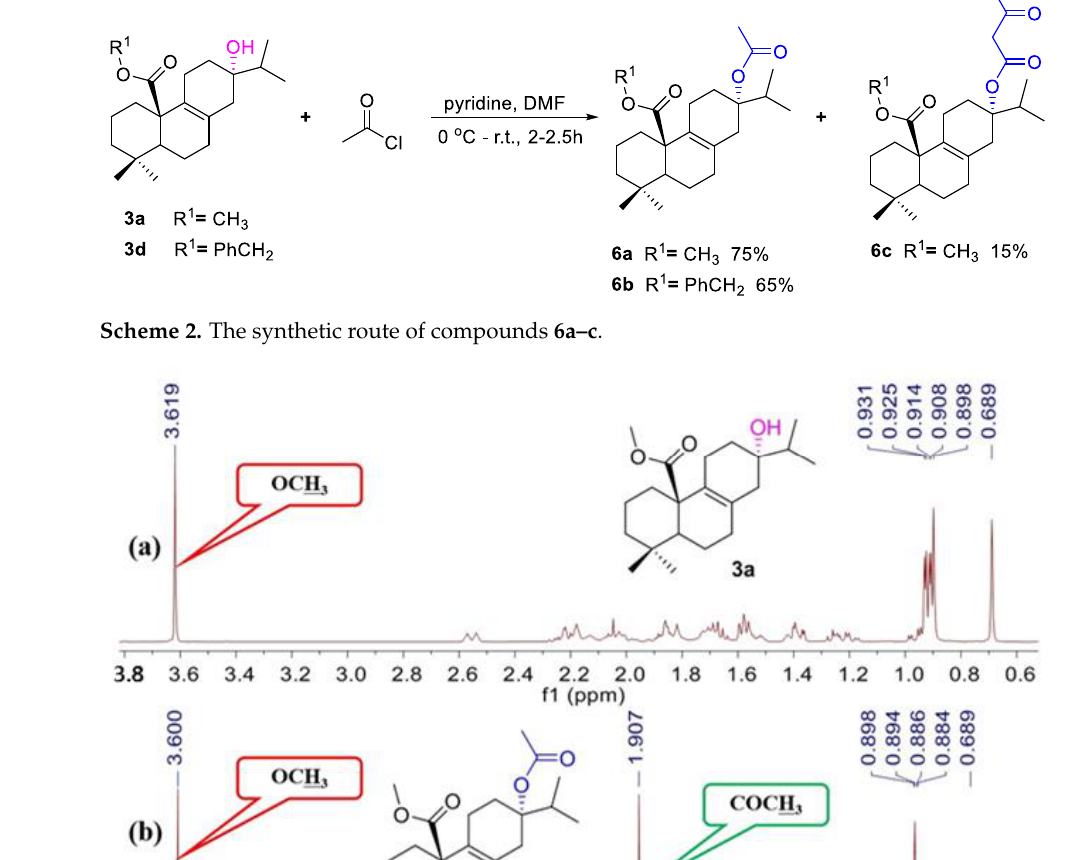
Figure 2. The 1 H NMR spectra of 3a ( a ), 6a ( b ), and 6c ( c ).